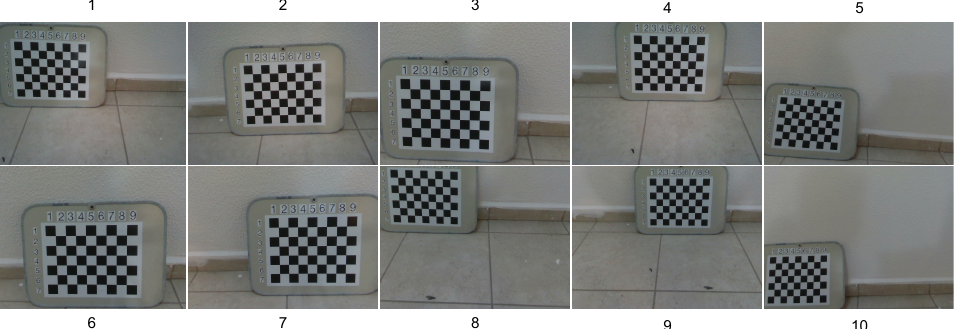
Figure 7. A set of ten different images with a chessboard in the scene are needed to use [43] in order to find the intrinsics and undistort RGB layer, implementation details is based in [45] and a toolkit is available by